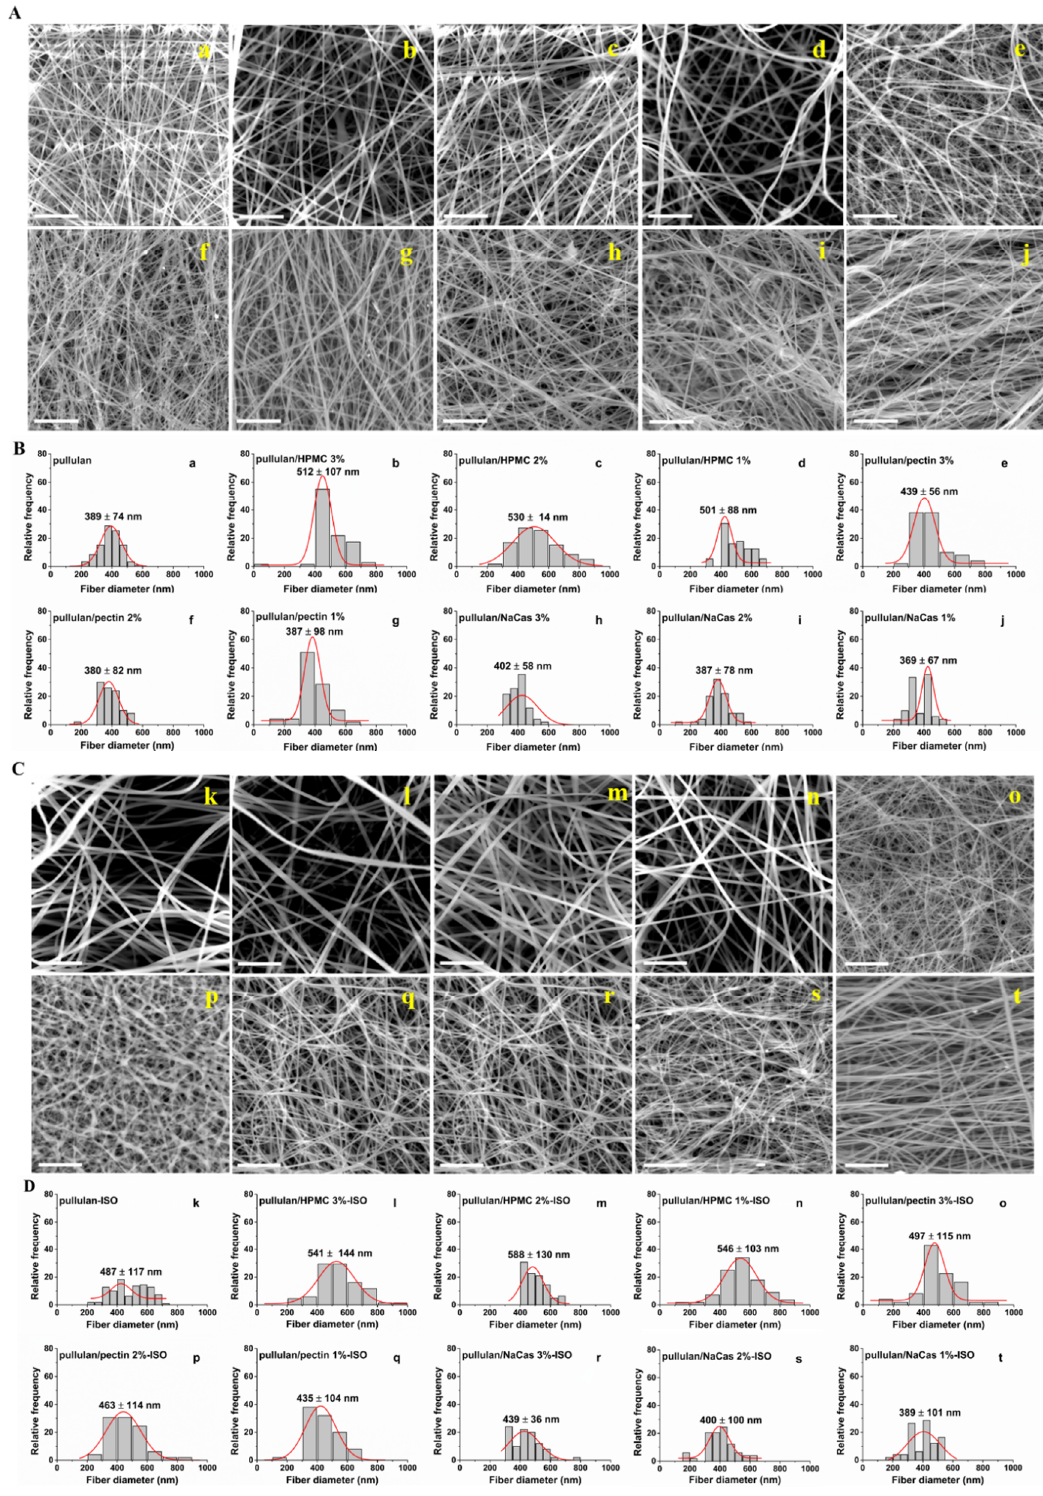
Figure 2. ( A ) and ( C ) SEM images of the ODF formulations containing ( a ) pullulan, ( b ) pullulan/HPMC 3%, ( c ) pullulan/HPMC 2%, ( d ) pullulan/HPMC 1%, ( e ) pullulan/pectin 3%, ( f ) pullulan/pectin 2%, ( g ) pullulan/pectin 1%, ( h ) pullulan/NaCas 3%, ( i ) pullulan/NaCas 2%, ( j ) pullulan/NaCas 1% and ( k ) pullulan-ISO, ( l ) pullulan/HPMC 3%-ISO, ( m ) pullulan/HPMC 2%-ISO, ( n ) pullulan/HPMC 1%-ISO, ( o ) pullulan/pectin 3%-ISO, ( p ) pullulan/pectin 2%-ISO, ( q ) pullulan/pectin 1%-ISO, ( r ) pullulan/NaCas 3%-ISO, ( s ) pullulan/NaCas 2%-ISO and ( t ) pullulan/NaCas 1%-ISO and their respective diameter distributions ( B ). ( a – j ) and ( D ). ( k – t ). Scale bar: 10 μm.